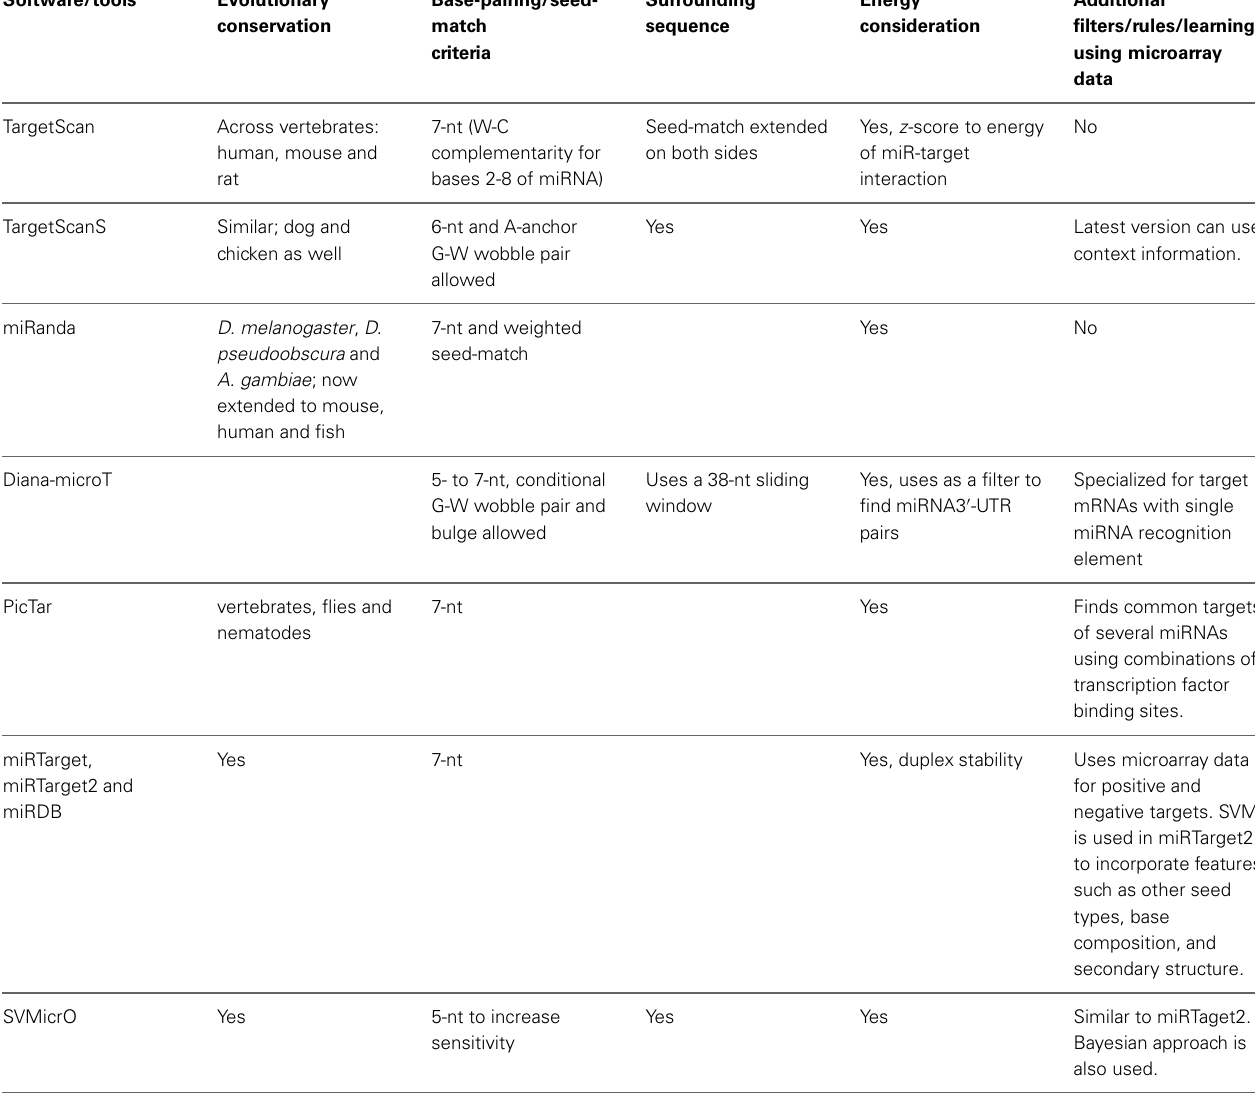
Table 1 | Commonly used computational tools and algorithms for identification of miRNA targets.